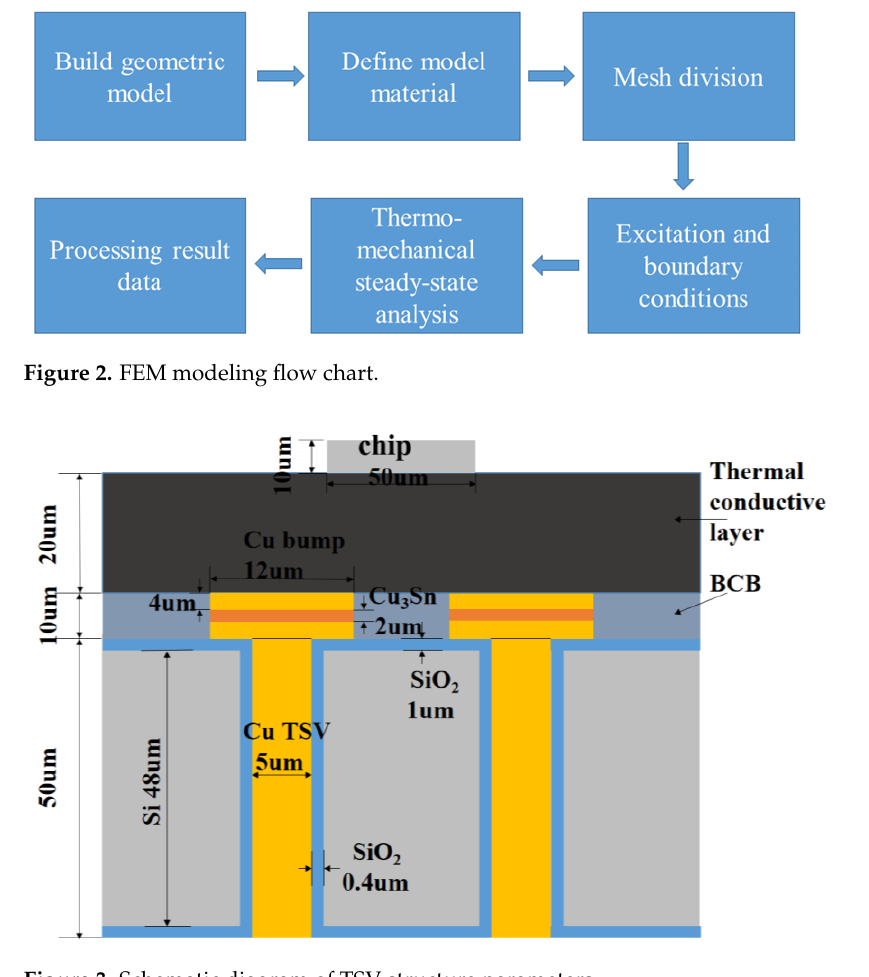
Figure 3. Schematic diagram of TSV structure parameters. Table 1. Materials and related physical parameters.